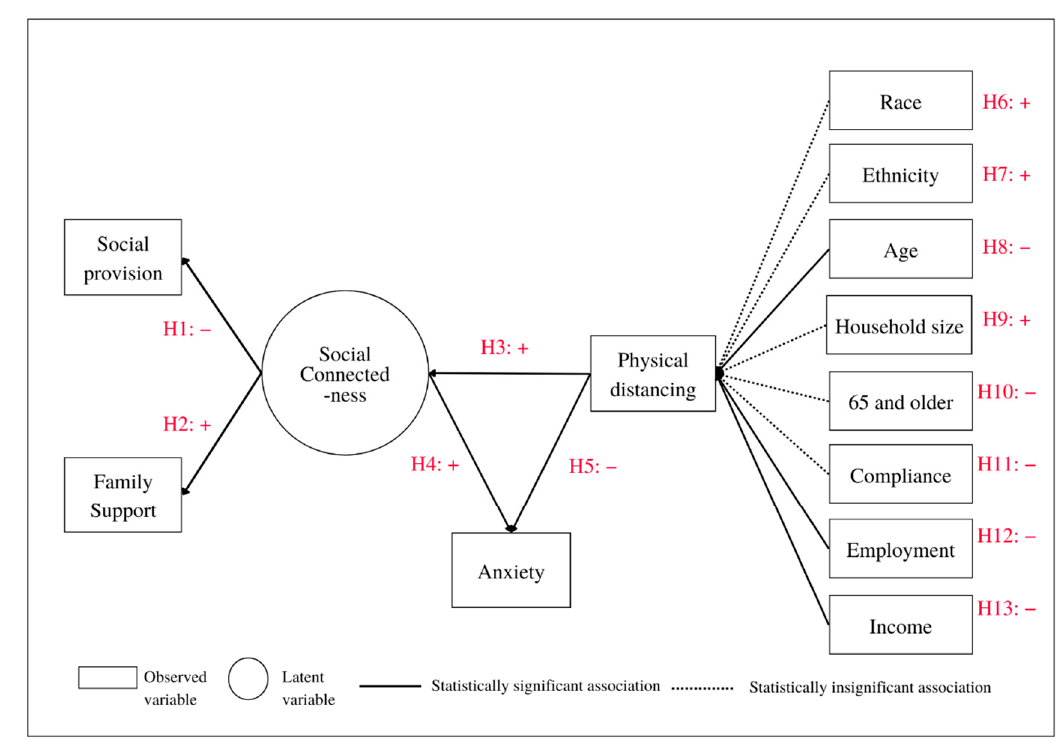
Figure 3. Validation of associations among study variables in the hypothesized structural equation model (SEM) of social connectedness, physical distancing, and anxiety (SCPDA).